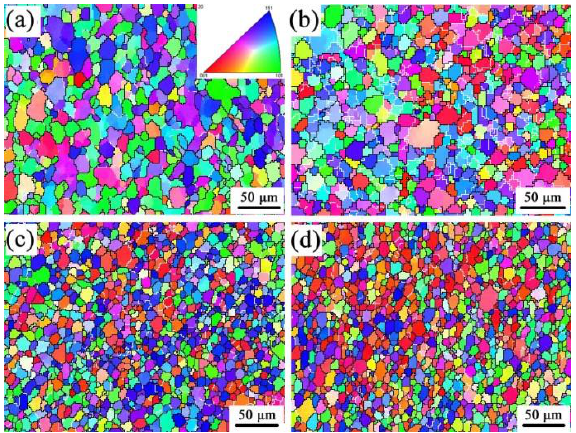
Figure 9. Electron backscattered diffraction (EBSD) micrographs of the SZ obtained at different rotational speeds: ( a ) 600 r/min, ( b ) 800 r/min, ( c ) 1000 r/min and ( d ) 1200 r/min. Table 3. Grain size in SZ at different rotational speeds.